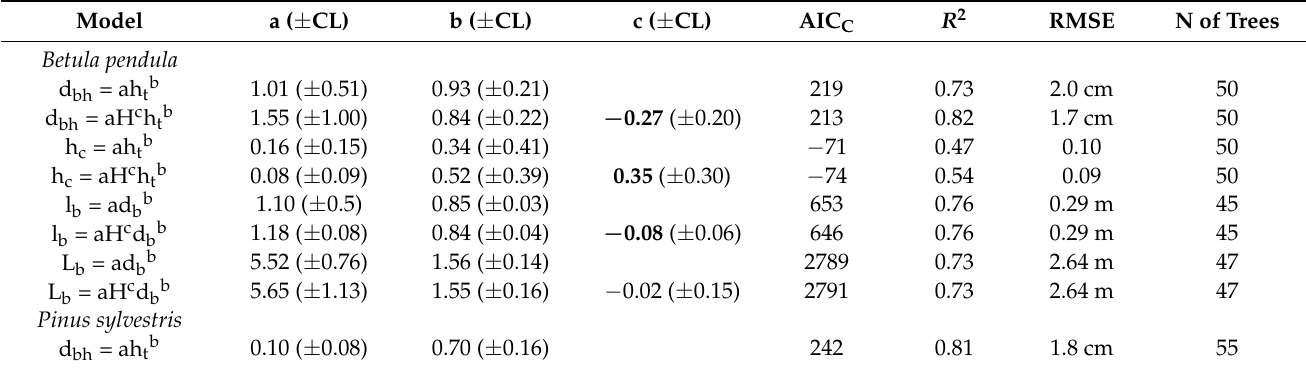
Figure 1. Black crosses show the observed values, red circles and blue lines show the values predicted by models with or without the effect of competition H , respectively. Table 2. Parameter values, fit statistics and the number of trees for the alternative models. Values of c in bold indicate cases where the 95% confidence limits (CL) do not overlap with